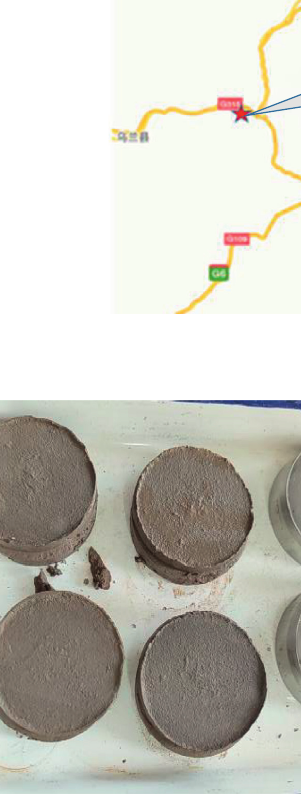
Figure 2: Preparation of soil sample.